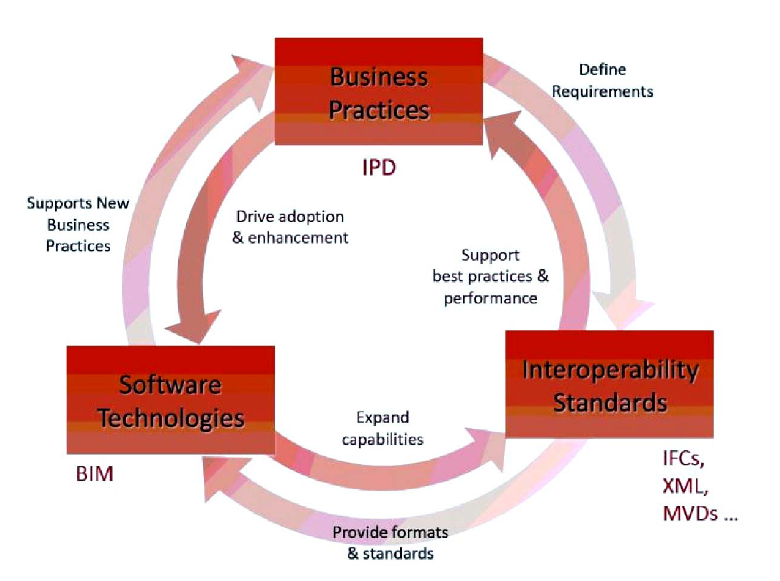
Figure 3. Interoperability and Architecture-Engineering-Construction (AEC) Practice